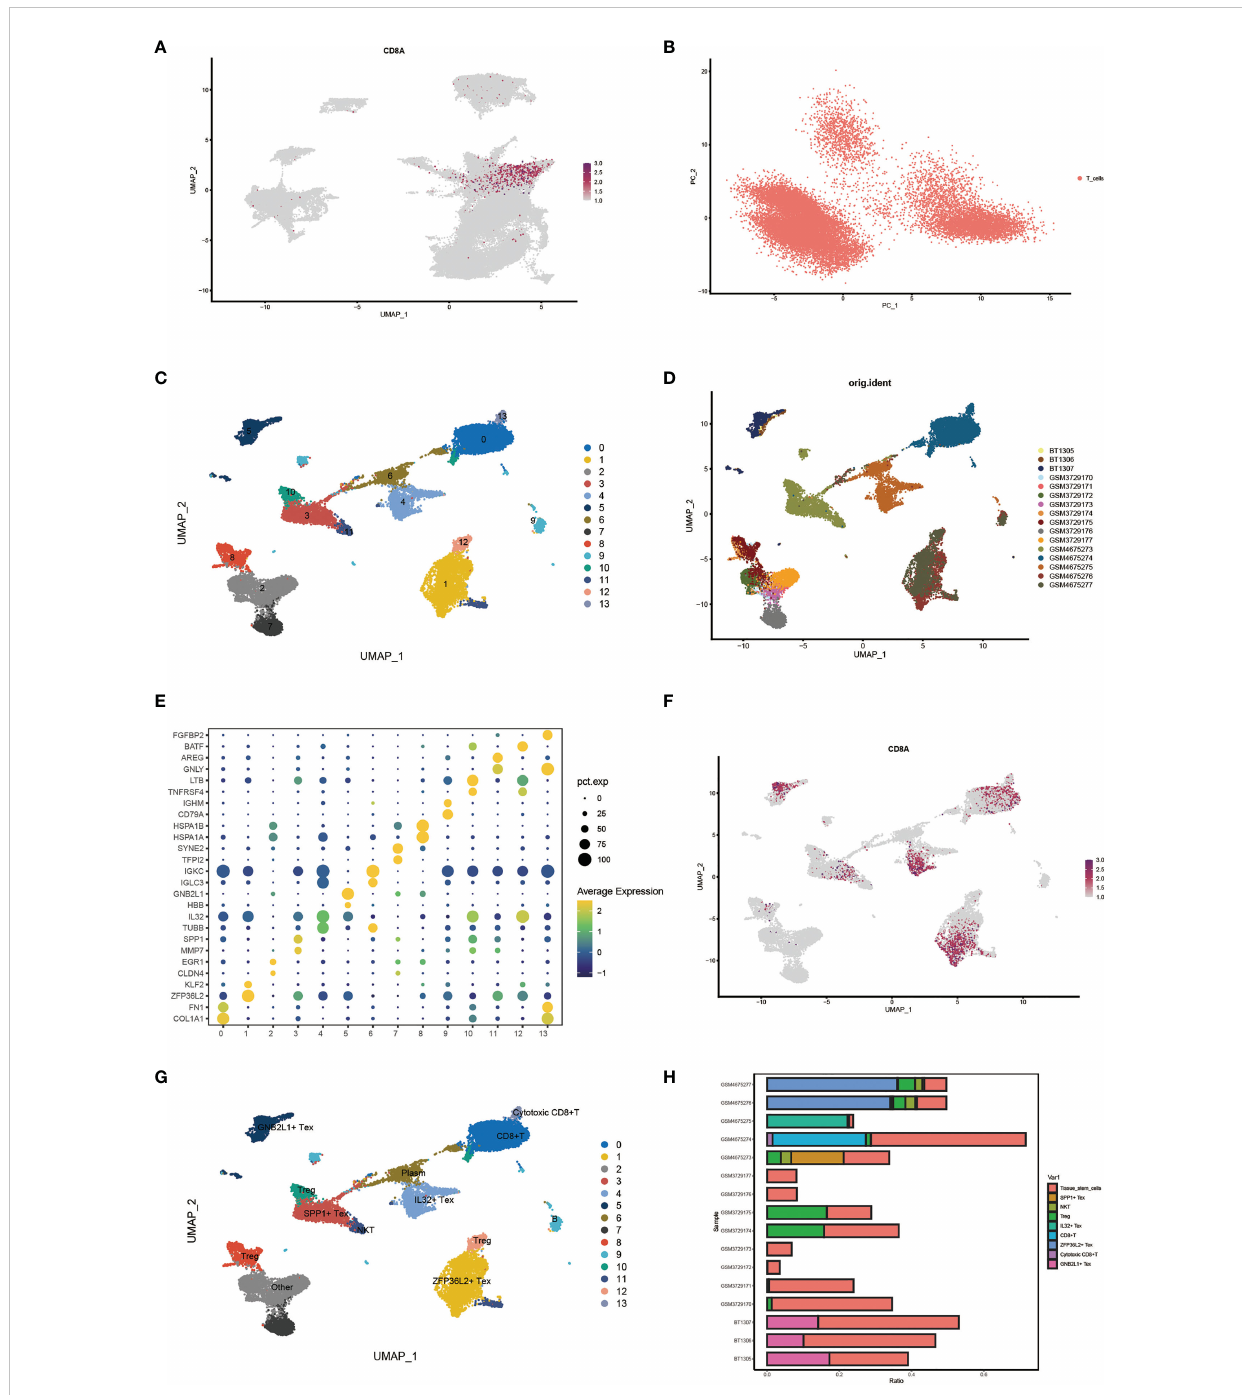
FIGURE 3 Identi fi cation of characteristic cell clusters. (A) View CD8 + T cell location by distribution of cell signature genes. (B) PCA Dimensionality Reduction Analysis of T Cell Clusters. (C) Umap shows 14 clusters of cells after dimension reduction. (D) Umap Plot of cell distribution by sample. (E) Bubble plots showing signature genes for each T cell subcluster. (F) Umap plot showing distribution of CD8marker. (G) Umap plots show results after annotation of T-cell clusters. (H) Histogram plot showing cell proportions for each